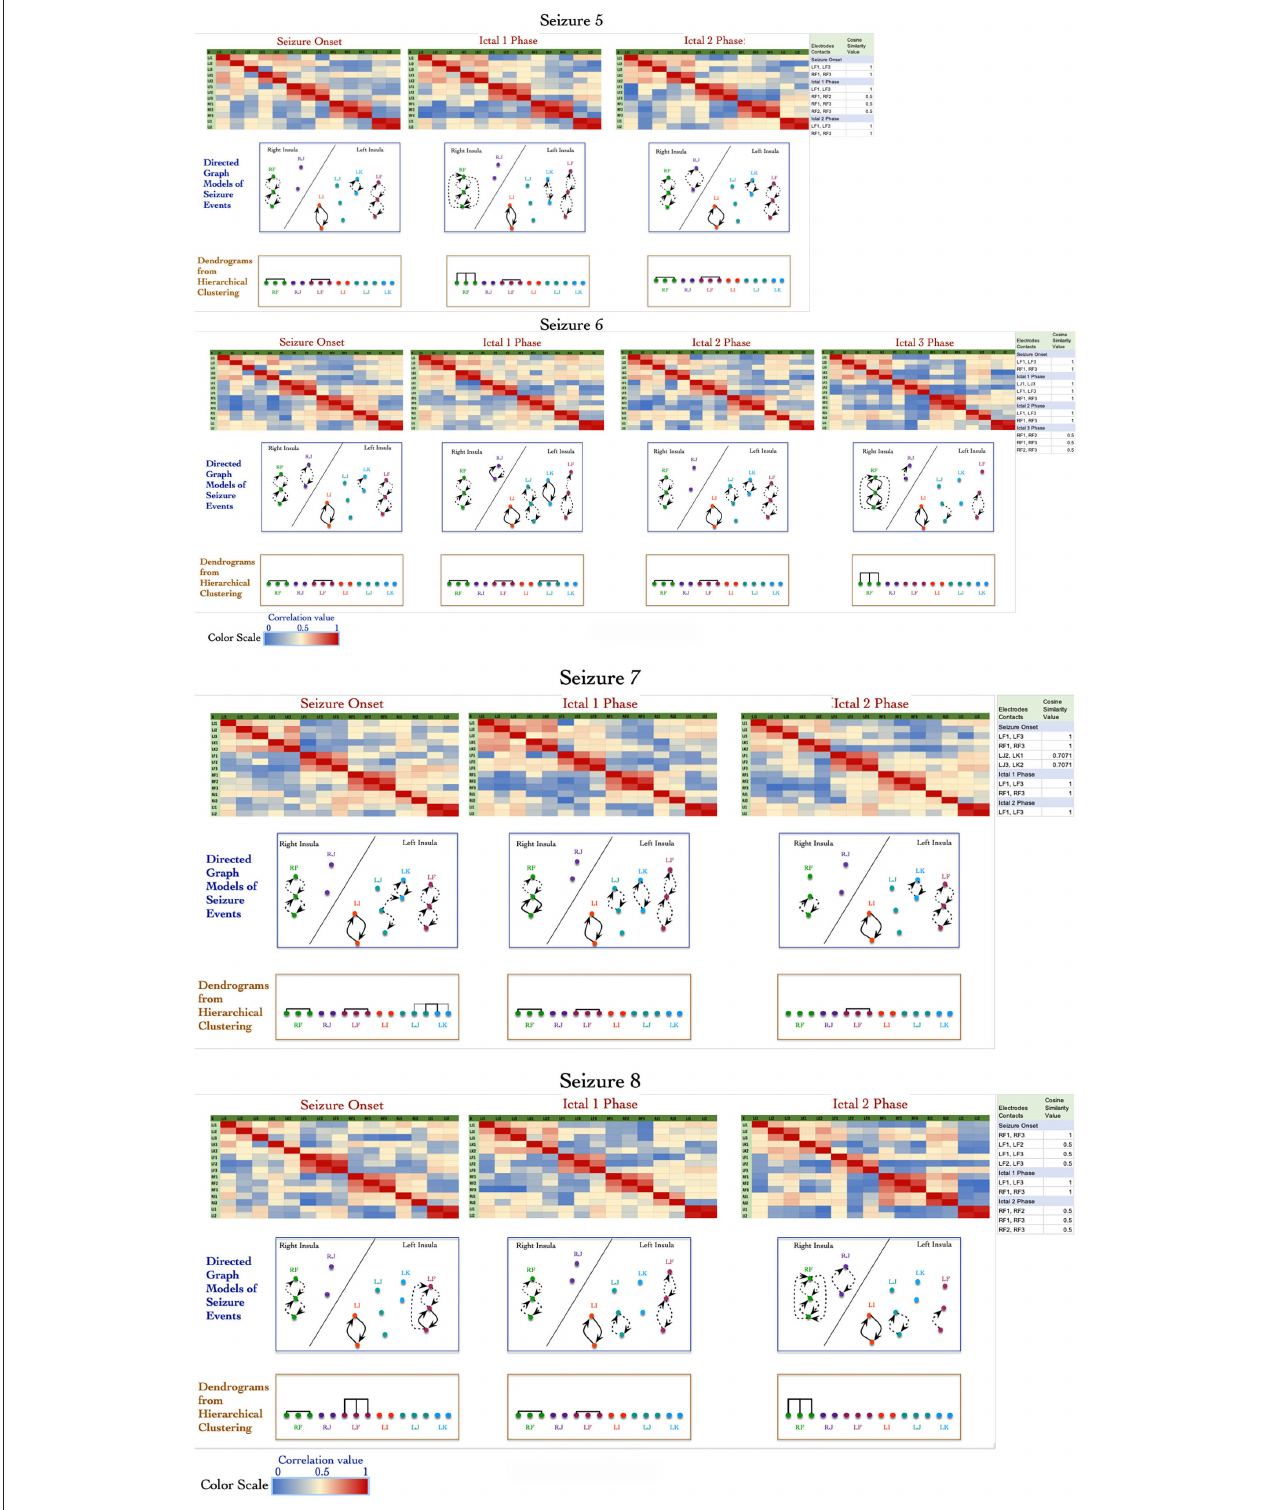
FIGURE 2 | Adjacency matrix representation of correlation values between electrode contacts during 27 events across 8 seizures derived from non-linear correlation coefficient measures using color to represent strength of coupling (red denotes stronger correlation and blue denotes weaker correlation). The directed graph structures derived from the correlation matrices using significant values with dashed lines representing lower and solid lines representing higher values. The modularity of the vertices in the graph are characterized using hierarchical clustering and visualized as dendrograms.